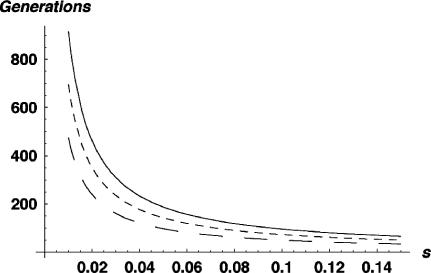
Time Required for a Favoured Variant to SpreadNumber of generations required for a favoured variant to go from an initial frequency of 0.001 to a final frequency of 0.1 (long-dashed line), 0.5 (short-dashed line), or 0.9 (solid line) as a function of the intensity of selection, s, assuming equation 1.